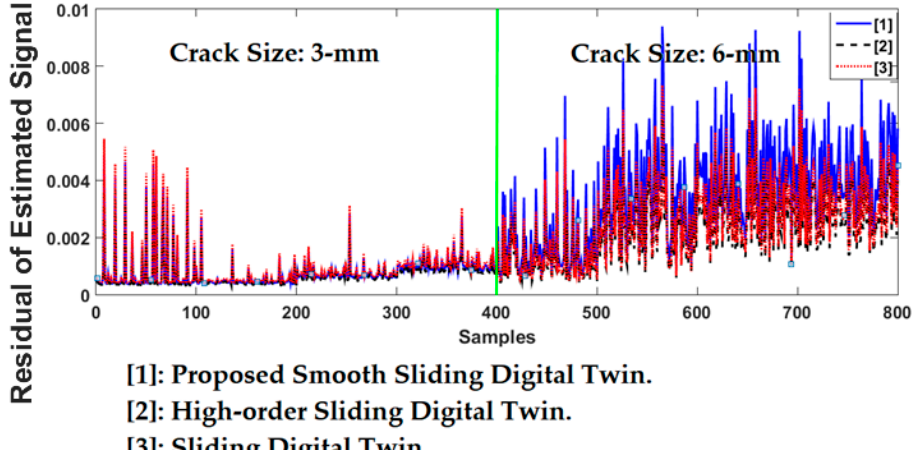
Figure 21. The accuracy of crack size identification for inner-outer-ball residual of RMS signals using proposed smooth sliding digital twin, high-order sliding digital twin, and sliding digital twin.